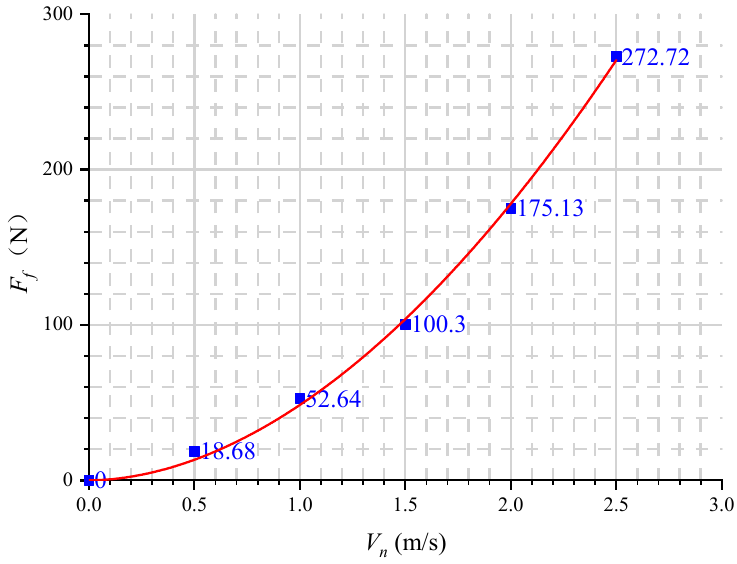
Figure 21. Velocity scalar nephogram at 2s moment at other four cruising speeds.